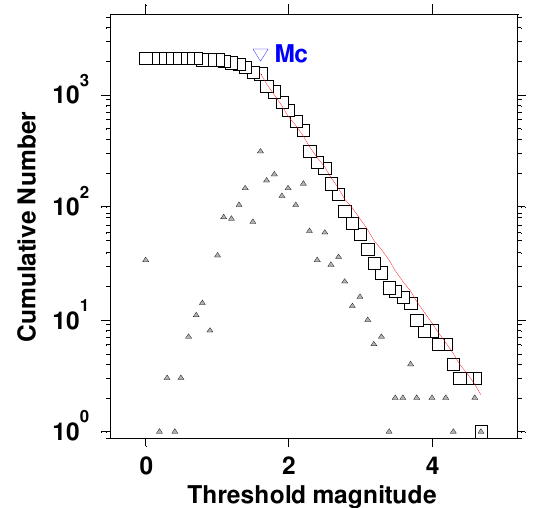
Fig. 2. Cumulative number of earthquakes vs. threshold magnitude during the period 1978-2010. The squares indicate the cumulative distribution, while the triangles indicate the binned frequency dis-